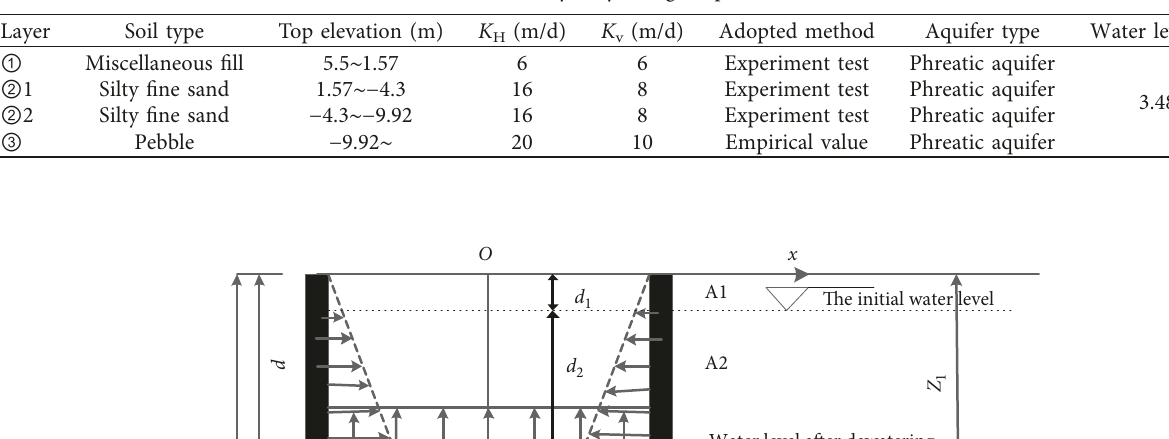
Table 2: Soil layer hydrological